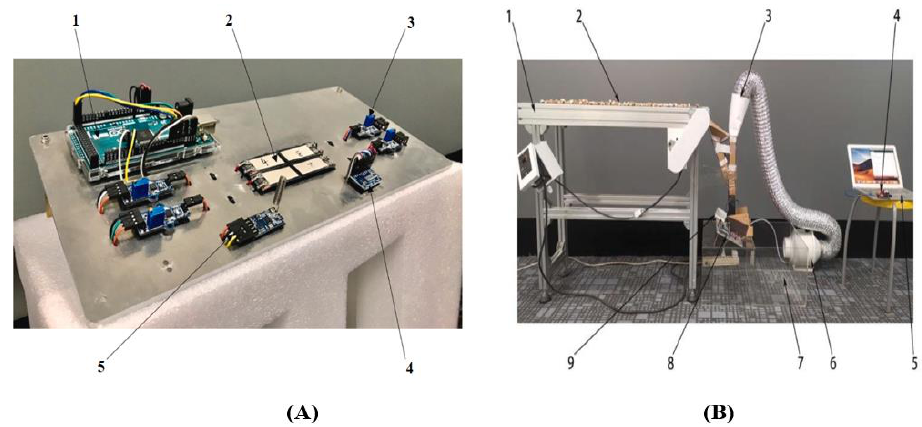
Figure 20. ( A ) The layout of the sensor impact; 1 — MCU, 2 — sensor, 3 — amplifier, 4 — A/D converter, 5 — wireless transmission. ( B ) Experimental platform; 1 — conveyor, 2 — grain and residue, 3 — air duct, 4 — data receiver, 5 — data processing, 6 — fan, 7 — recycling box, 8 — impact plate, 9 – power bank [56].